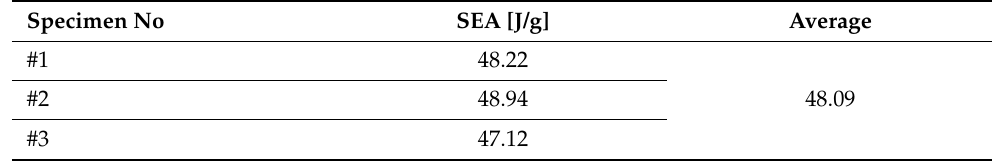
Figure 9. The results of the semi-circle specimens: load-displacement curve ( left ) and the deformed shape ( right ). Table 3. SEA values of semi-circle specimens.